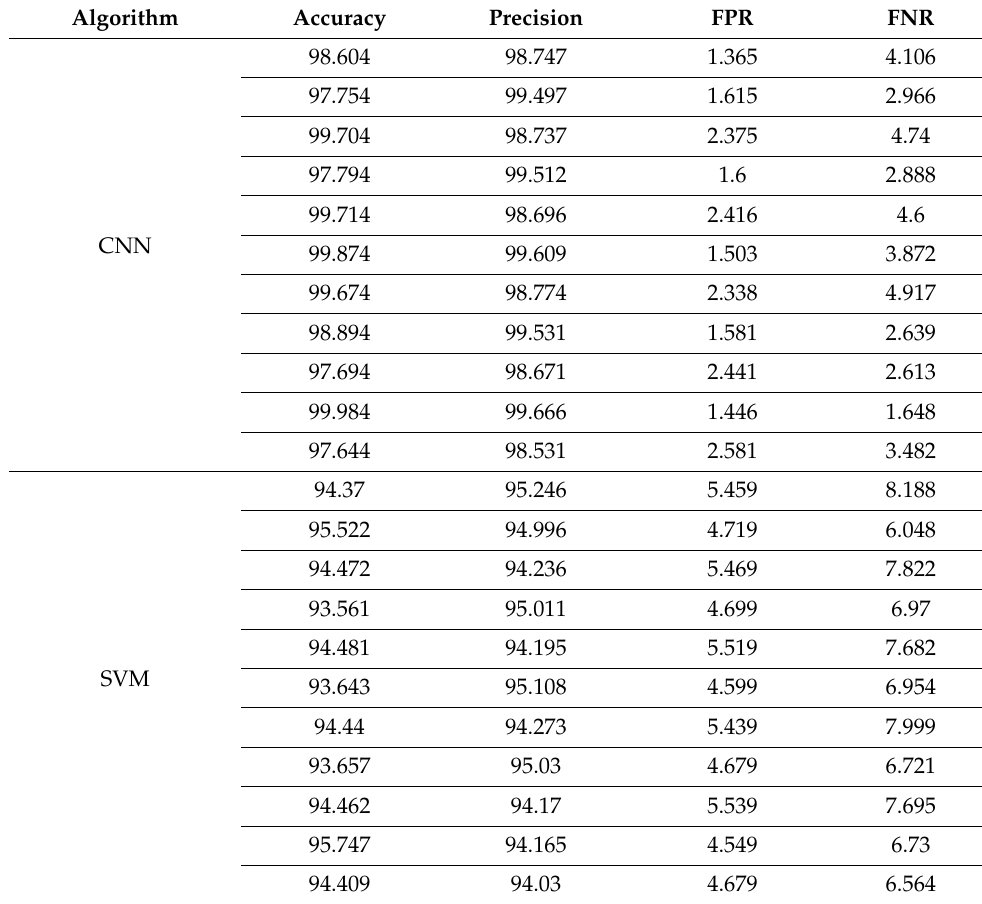
Table 7. 11-epoch performance values of accuracy, precision, false positive and false